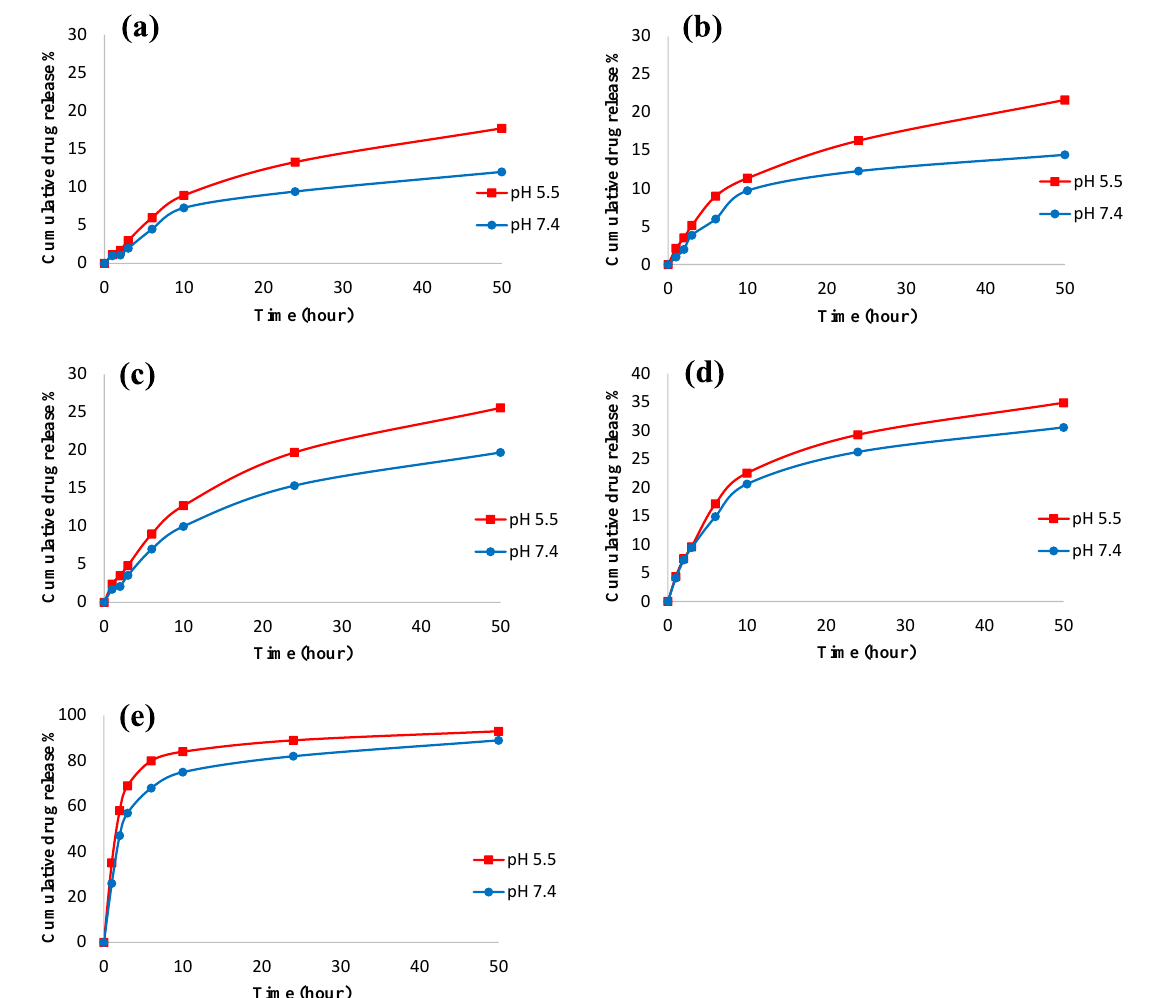
Figure 7. In vitro DOX release profiles for ( a ) G2PBG 15 - g -PEO/DOX, ( b ) G2PBG 29 - g -PEO/DOX, ( c ) G2PBG 65 - g -PEO/DOX, ( d ) G1PBG 29 - g -PEO/DOX unimolecular micelles, and ( e ) free DOX in PBS (pH 7.4 and 5.5) at 37 °C.